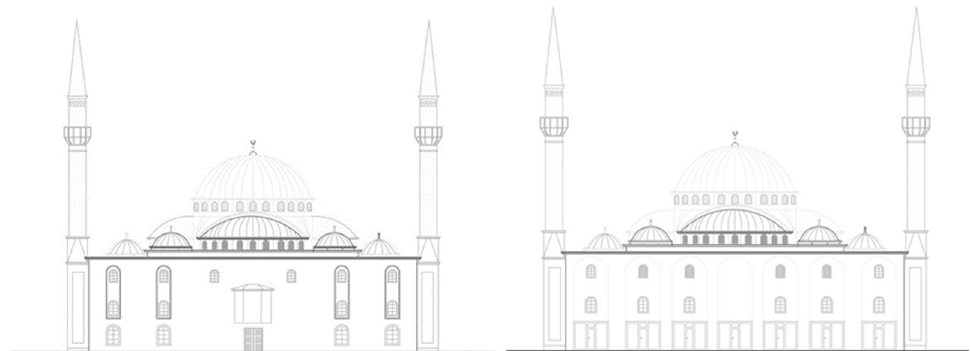
Figure 12. The Guzeloba Mosque’s south façade, drawn in the construction permit/south façade in the current use.